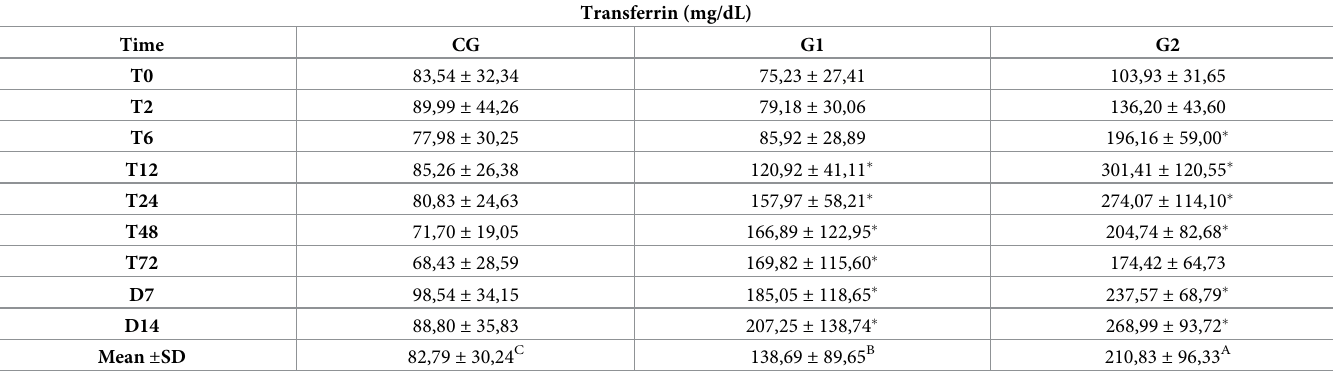
Table 12. Mean and standard deviation (SD) of transferrin in the peritoneal fluid of healthy horses (CG) and horses submitted to cecal trocarization with a cecal needle (G1) or a cattle trocar (G2).